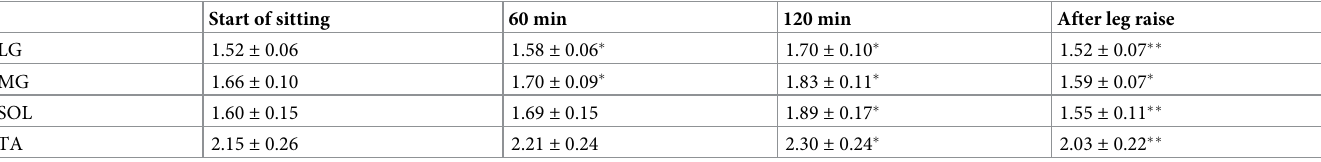
Table 1. Shear wave velocity of LG, MG, SOL, and TA over